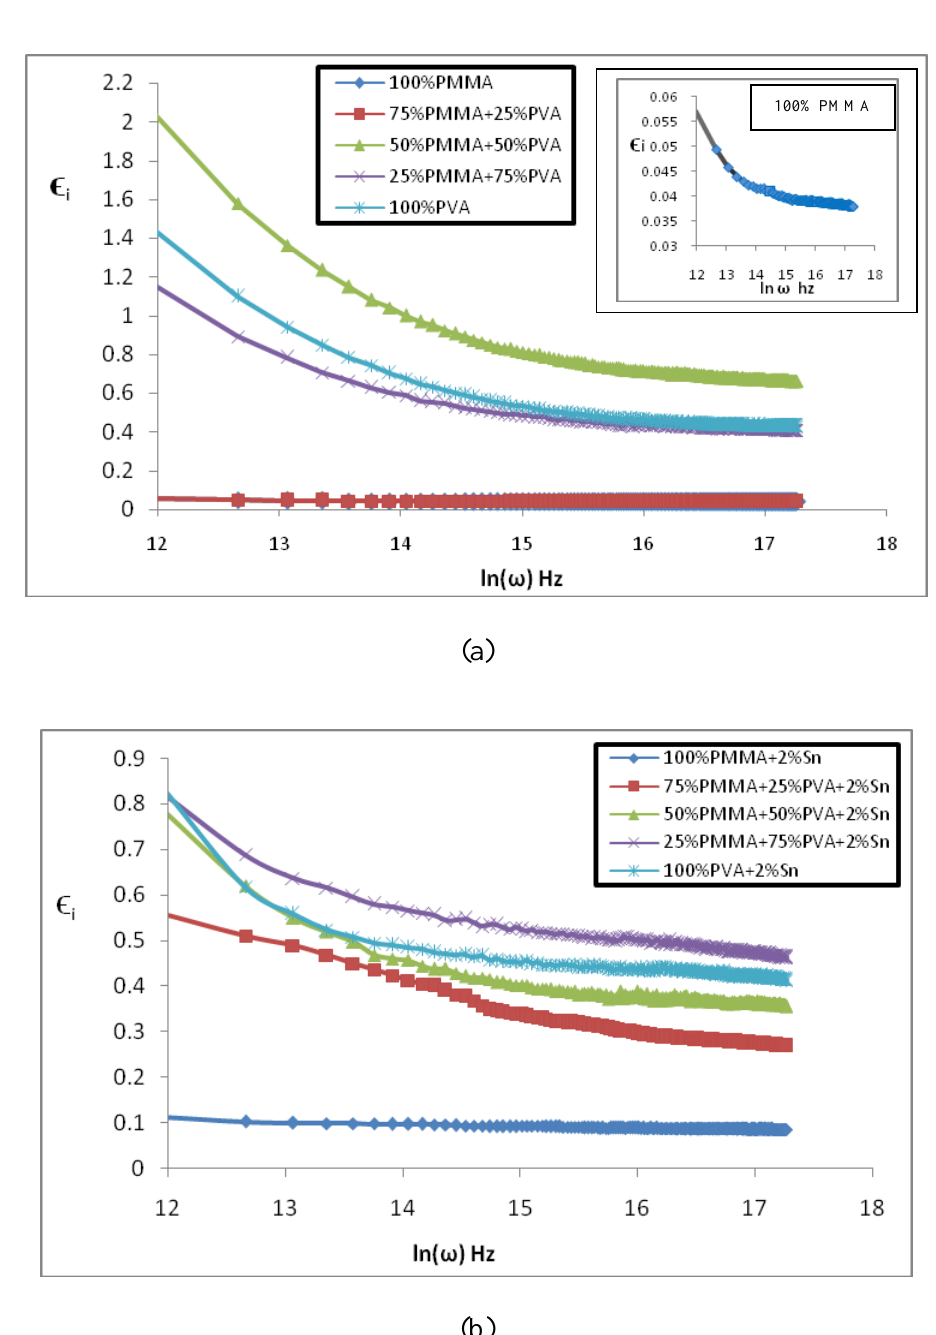
Fig. 2: Variation of ϵ with ln (ω) for PMMA/ PVA blends (a)Undoped (b) Doped with 2% Sn. i 2- Frequency dependence of σ a.c ( ω